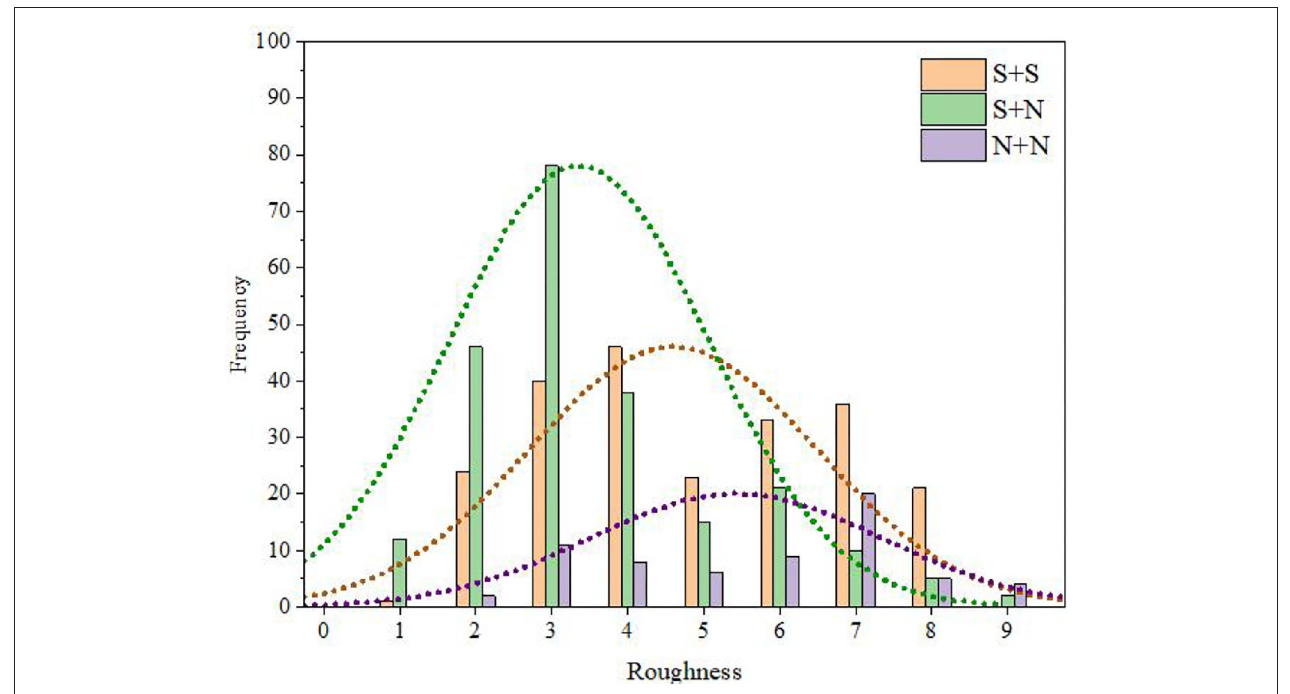
FIGURE 12 | Distribution statistical histogram of roughness category.